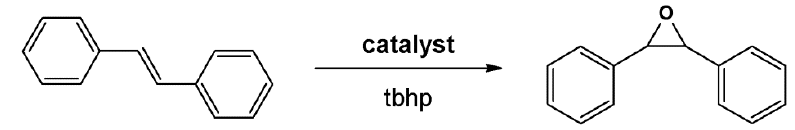
Figure 9. Epoxidation of trans -stilbene by a series of MOF and a cobalt porphyrin in homogeneous medium